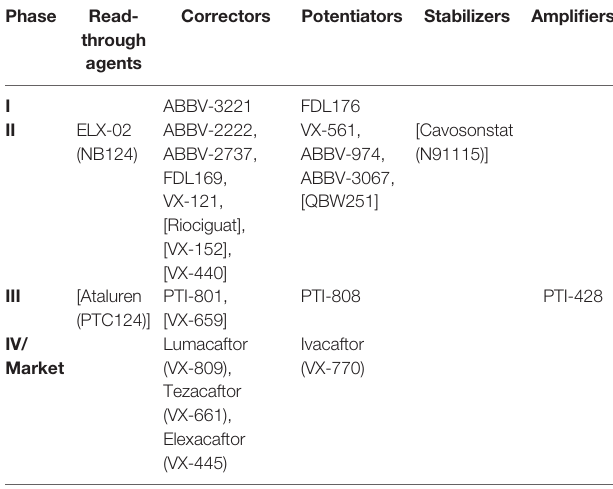
TABLE 2 | Pipeline of CF transmembrane conductance regulator (CFTR) modulators in clinical trials and in the market ( # ). Phase Read-